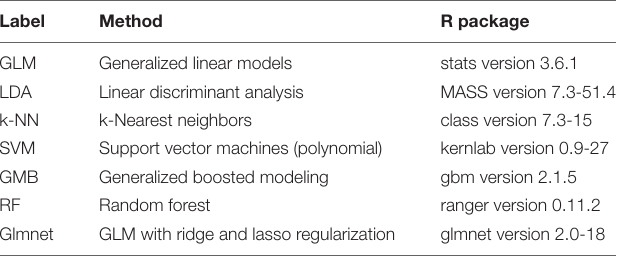
TABLE 7 | Machine learning models used with corresponding R statistical analysis package.